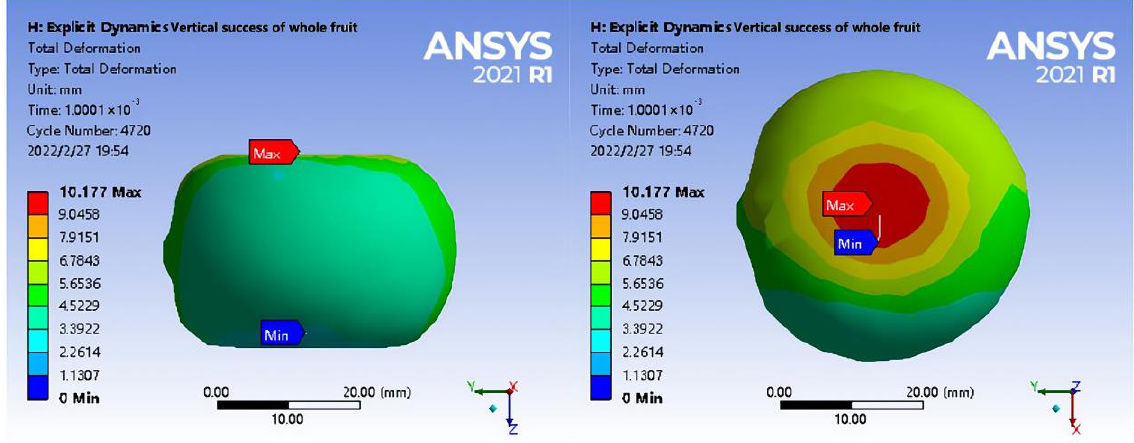
Figure 12. Total strain diagram under radial loading.